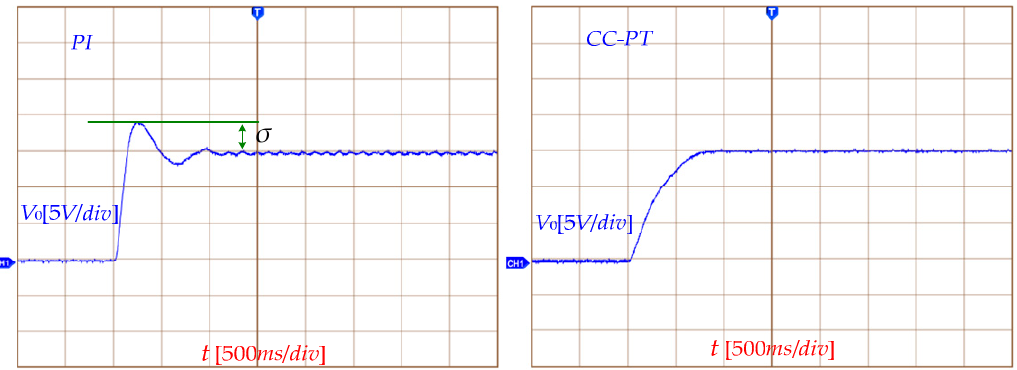
Figure 15. The starting process under the control of PI and CC-PT.